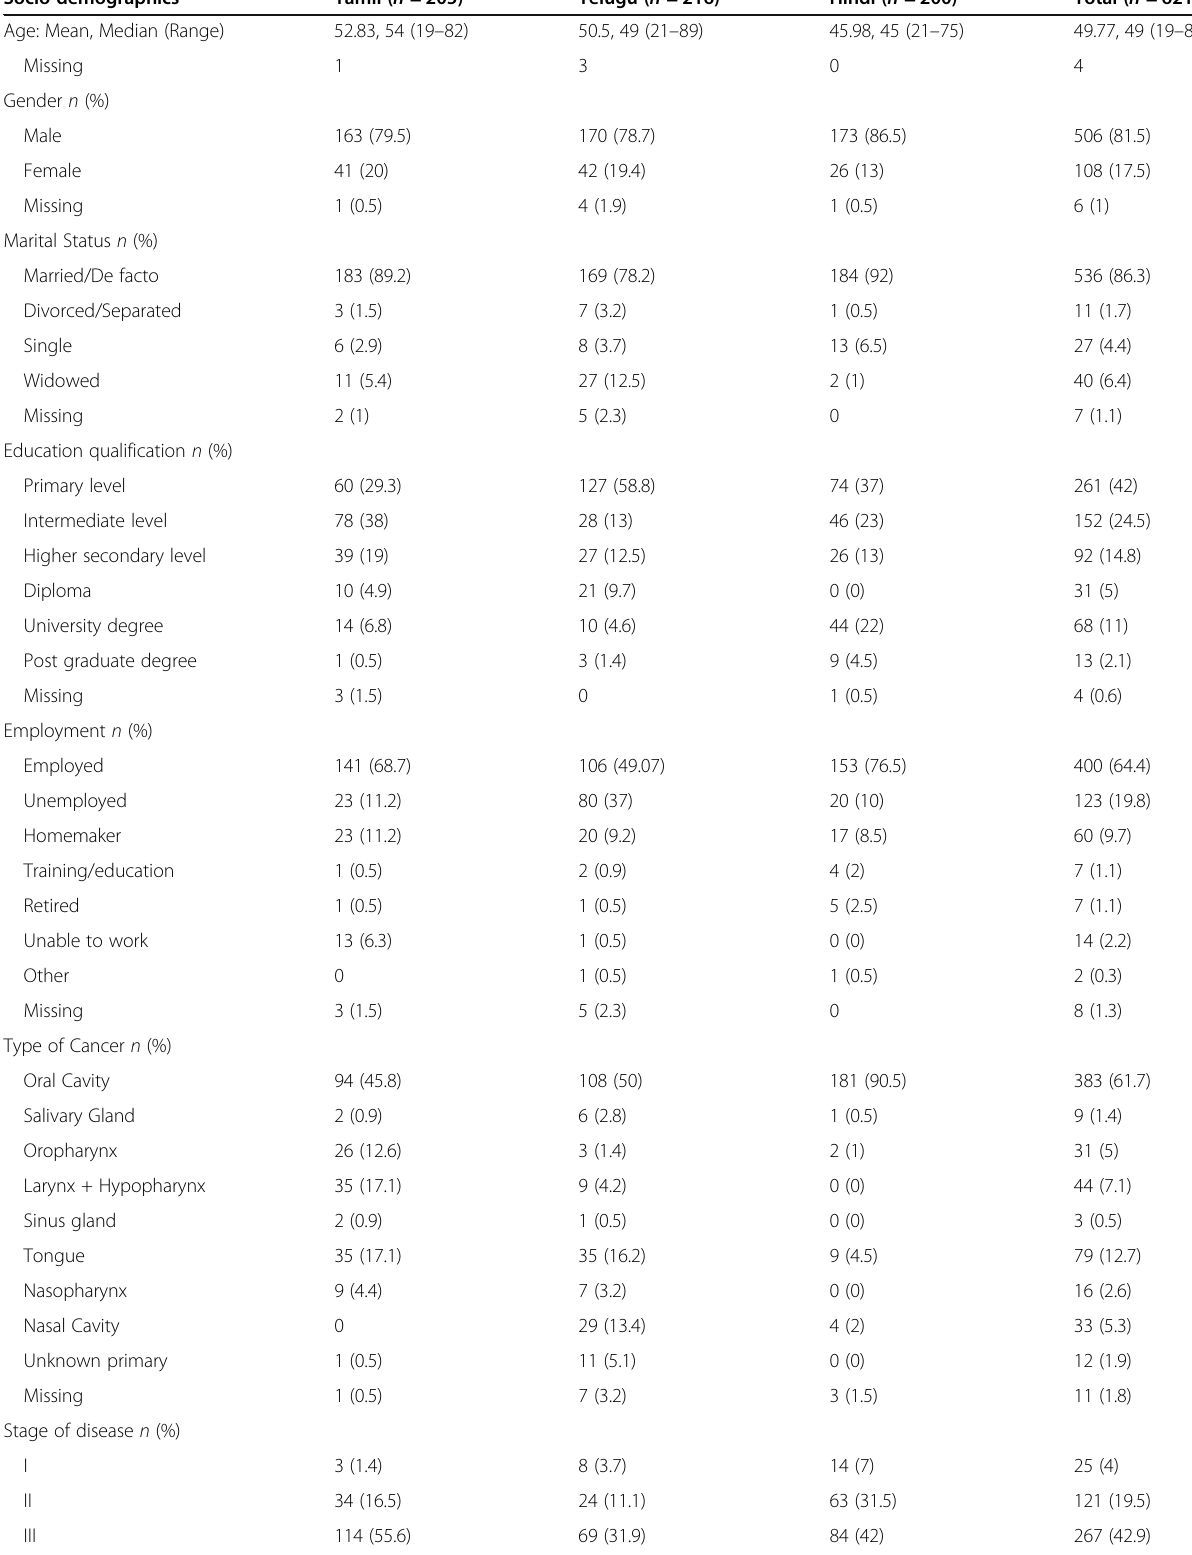
Table 1 Sociodemographic and clinical characteristics for 621 patients across languages and in